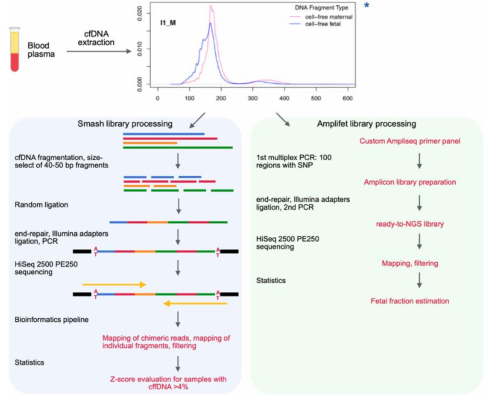
Figure 1. Schematic of NIPT (non-invasive prenatal testing) based on long-chimeric-read sequencing. Extracted cfDNA was divided into two pipelines in parallel: smash (blue) for aneuploidy evaluation and amlifet (green) for c ff DNA fraction estimation. For the smash library, cfDNA was additionally fragmented to 40–50 bp fragments, and then was randomly ligated into long chimeric molecules. Whole chimeric reads were mapped to reference genome to identify each fragment’s ends. Fragments were then mapped as individual short reads. For the amplifet library, cfDNA was amplified with a primer pool to simultaneously obtain 100 amplicons with SNPs of interest. The amplicon library was then sequenced. An SNP was considered useful to estimate fetal fraction if maternal genotype was homozygous and fetal genotype was heterozygous. If fetal fraction > 4%, aneuploidy statistical test was performed with smash data. * chart from Reference